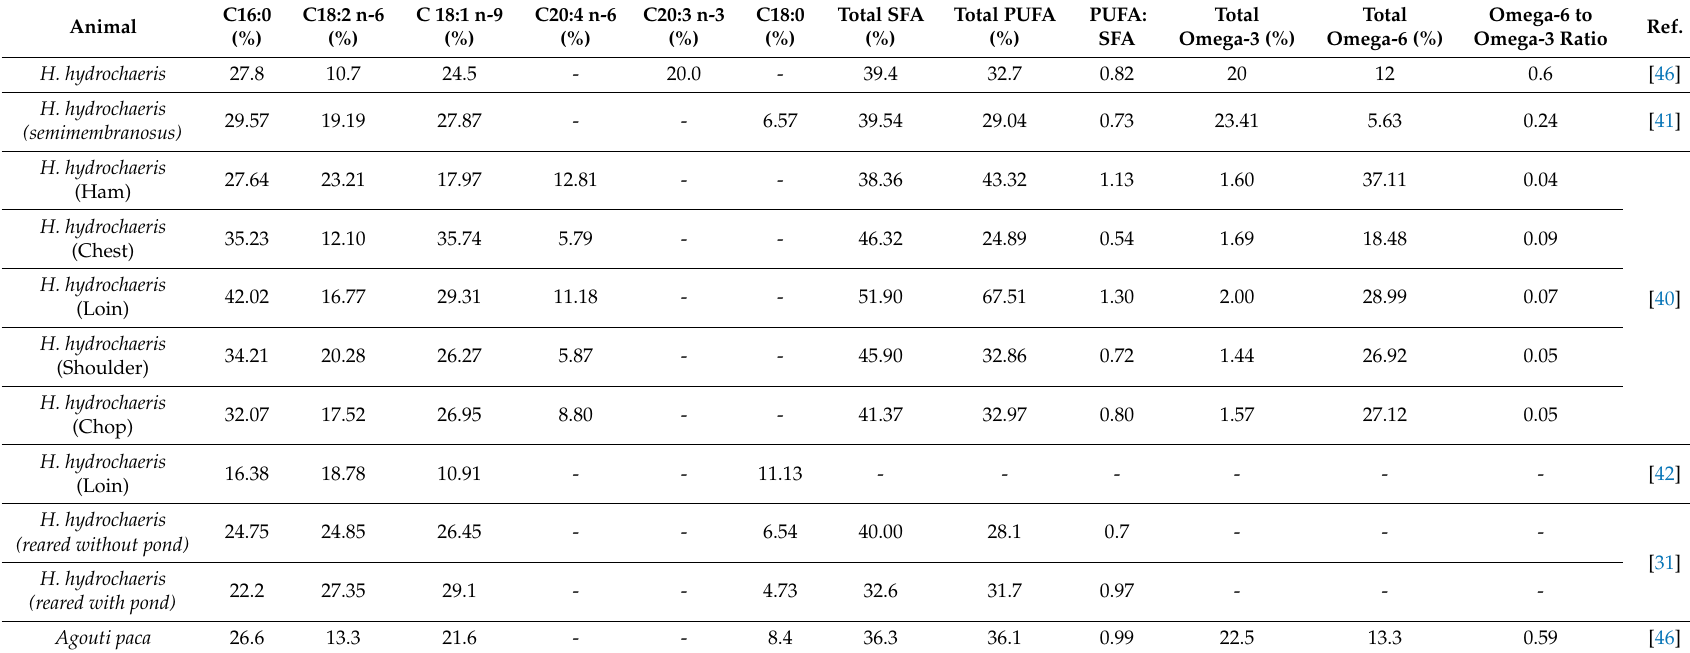
Table 2. Fatty acid composition of capybara and lappe